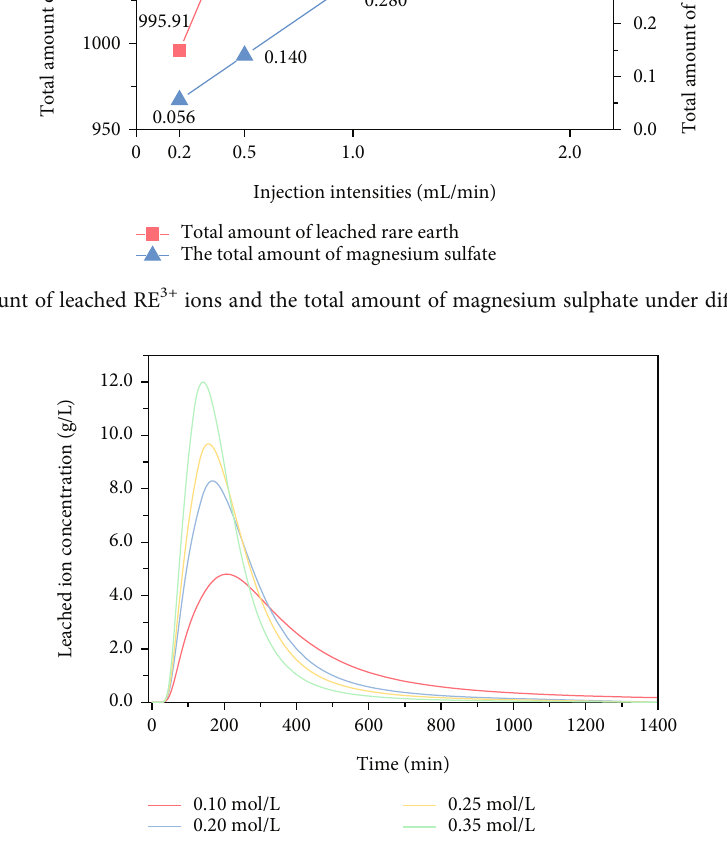
Figure 13: Variation curve of RE 3+ ion leaching concentration with di ff erent leaching agent